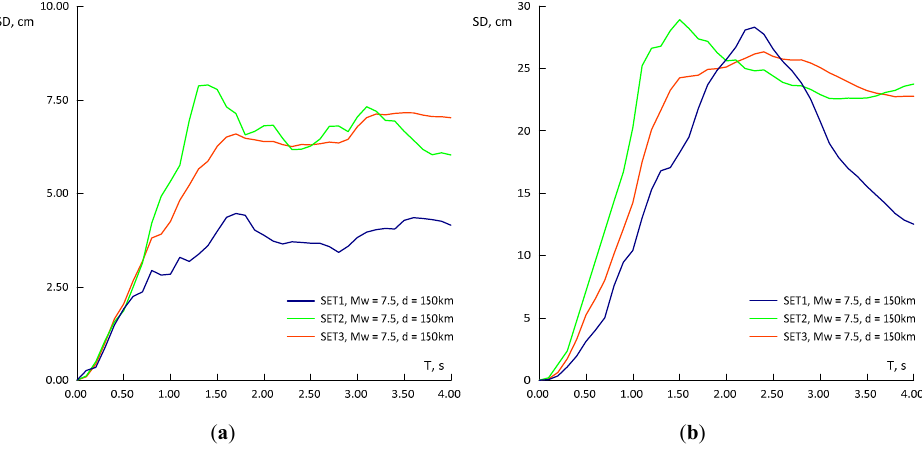
Figure 14. Prediction of a seismic event with M W = 7.50 and D epi = 150 km, median values, the three sets ( a ) soil type B ( b ) soil type C.